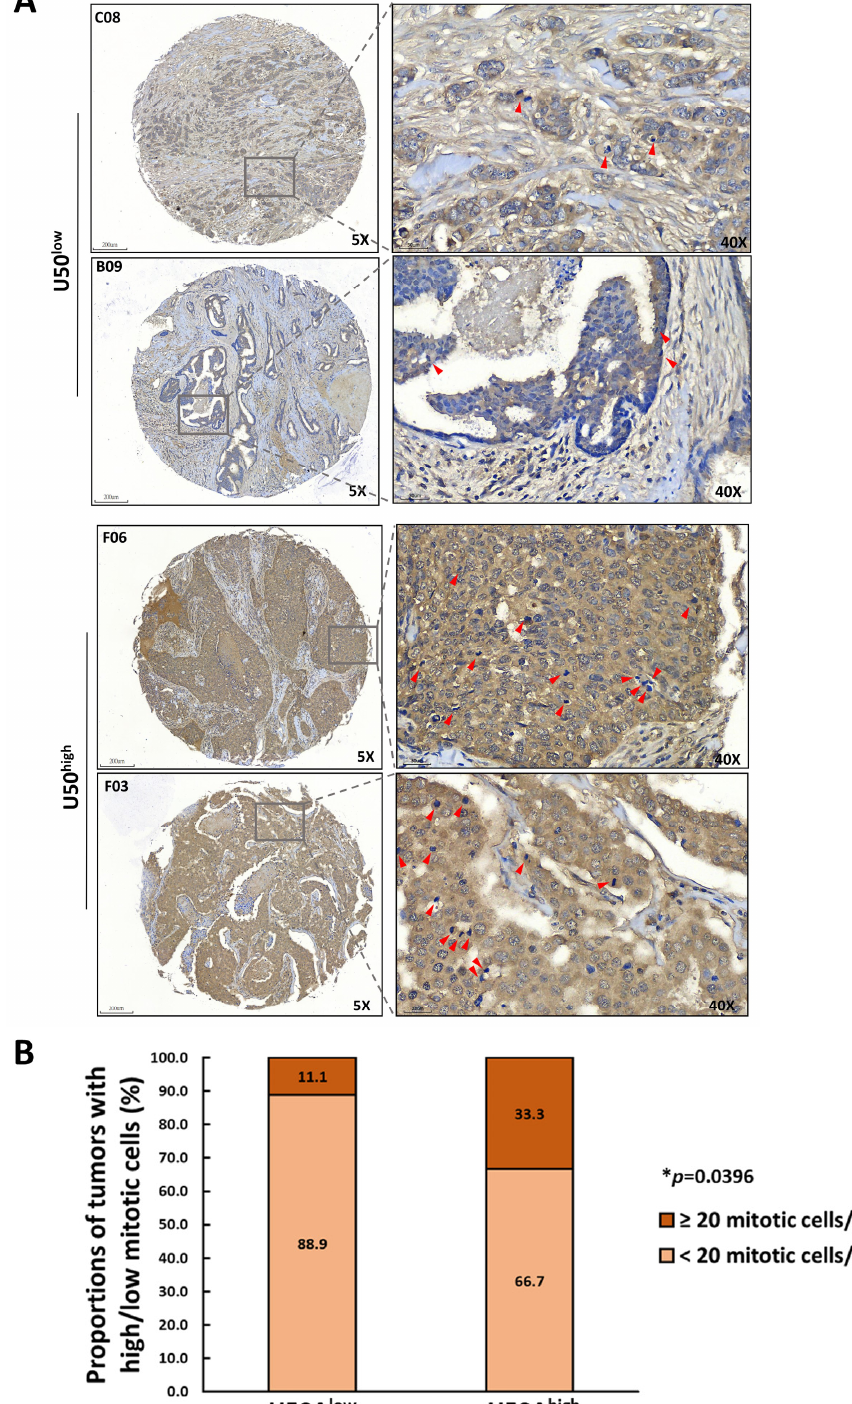
Figure 5. Correlation between U50A and mitotic cells in breast cancer patients. A breast cancer patient tissue array (BRC1021) was applied for in situ hybridization (ISH) of U50A. ( A ) Representative images of U50A in situ hybridization. The top and bottom panels show the U50A-low/U50A-high breast cancer patients, respectively, and enlarged images are on the right. Red arrowheads indicate mitotic cells. Scale bar = 200 µ m (5 × ); 30 µ m (40 × ). ( B ) Quantitated result of mitotic cells in U50A-low/high samples from ISH images. HPF, high-power field. Fisher’s exact test was used. * p <